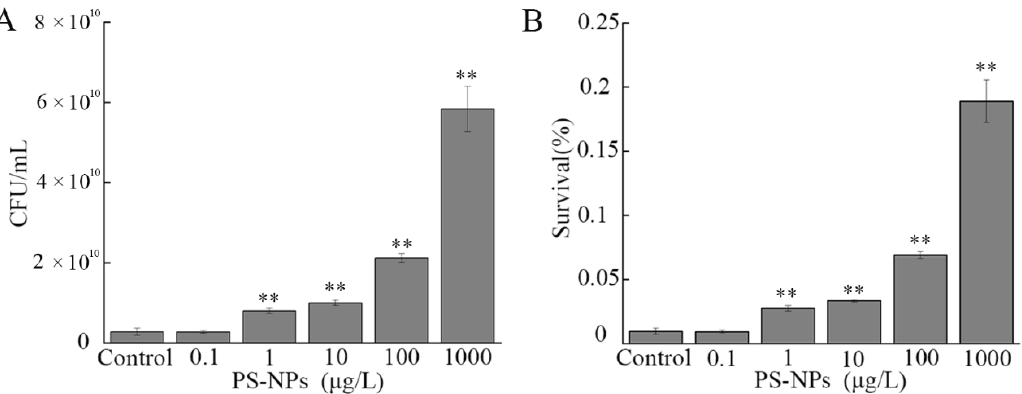
Figure 6. Effect of nanopolystyrene particle (NP) exposure on serum resistance of A. johnsonii AC15. ( A ) Colony-forming unit (CFU) of A. johnsonii AC15 in normal human serum (NHS) after exposure to NPs. ( B ) Survival rate of A. johnsonii AC15 in NHS after exposure to NPs. ** p < 0.01 vs. Control.